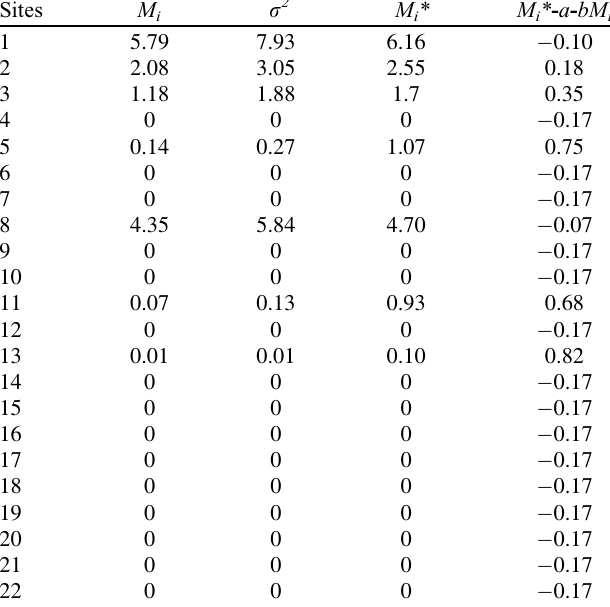
Table 6. The calculated mean ( M i ), variance ( r 2 ) and Lloyd ’ s mean crowding ( M i * ) in different sampling units in Iwao ’ s linear regression analysis and the signi fi cance test of deviation ( F test).